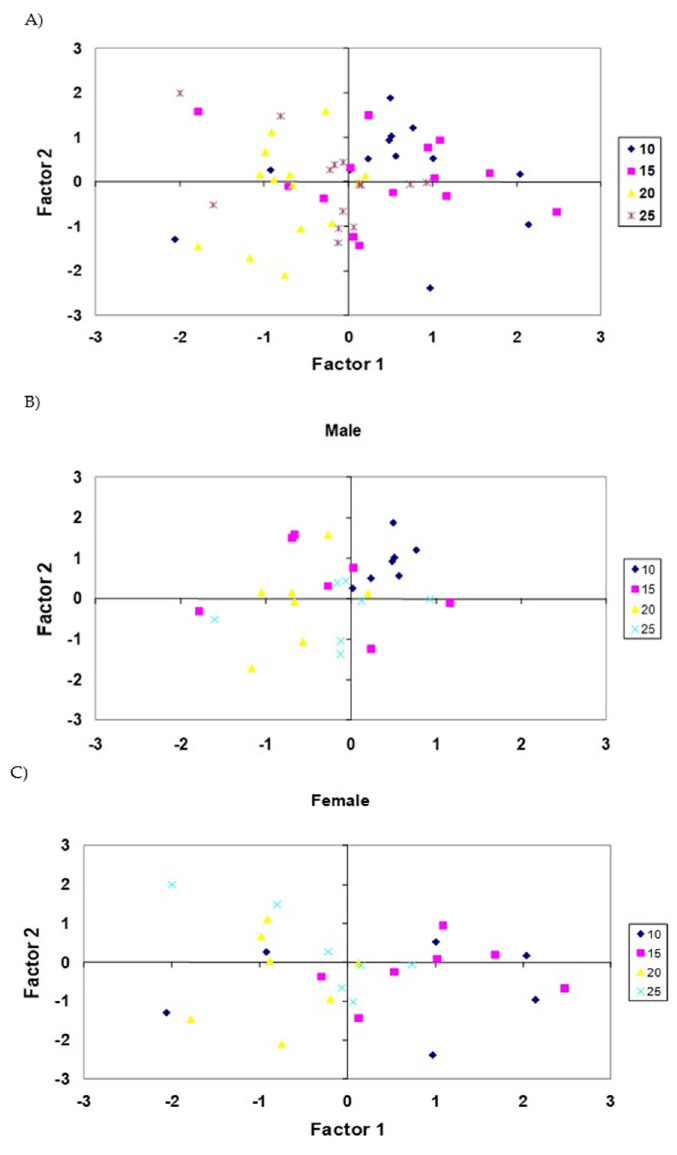
Figure 3. Projection of the sensory quality data of the 10, 15, 20, and 25 kg groups studied in the plane defined by the two principal components. ( A ) All the animals studied in this work, ( B ) male group, ( C ) female group.